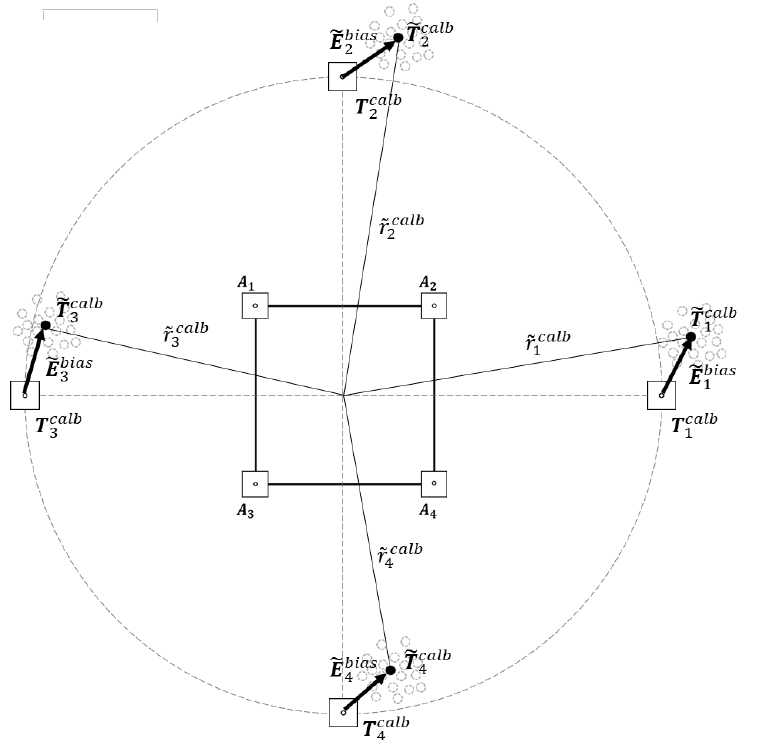
bias . Initial calibration is conducted prior bias norm